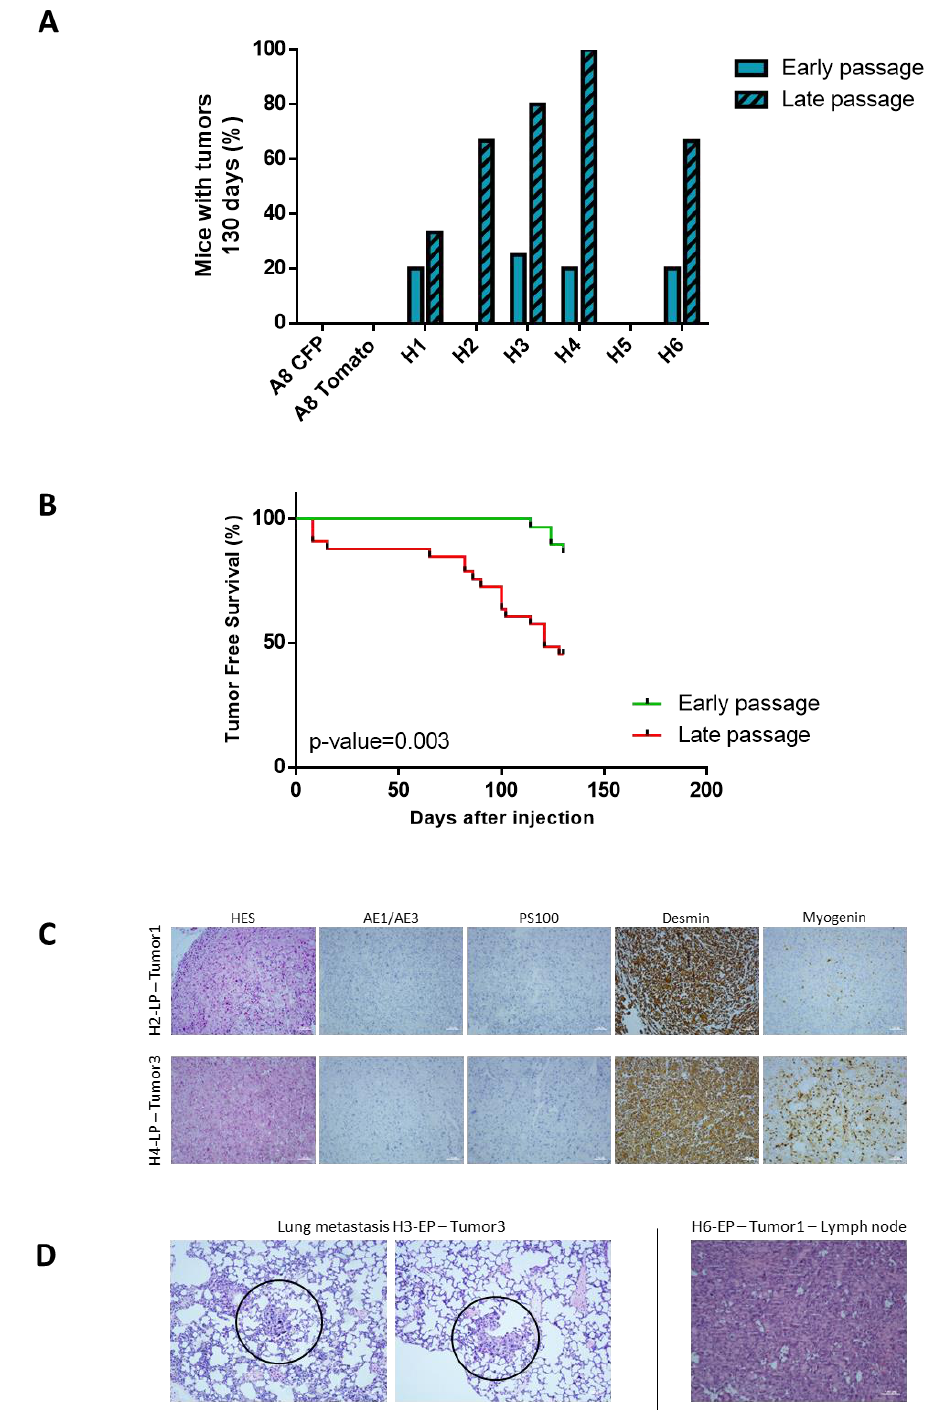
Figure 3. Hybrids develop tumors in mice and late passage cell lines are more aggressive. ( A ) Frequency of tumor development for parental and hybrid cell lines at early and late passage. ( B ) Tumor-free survival analysis comparing tumor development from early or late passage hybrid cell lines. p -value = 0.003 with Mantel-Cox test. ( C ) Hematoxylin and eosin (HE) staining and immunohistochemistry (IHC) analysis of hybrid tumors. Scale bar = 100 µm. ( D ) Lung and lymph node metastasis detected by HE staining. Scale bar = 100 µm.